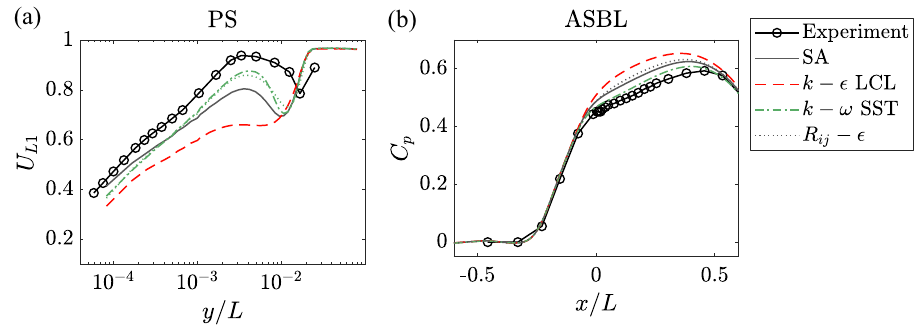
Figure 4. RANS results and the experimental data. Different lines are used for the results of different RANS models. Thin lines: SA model, dashed lines: k − ǫ LCL model, dot-dashed lines: k − ω SST model, and dotted lines: R ij − ǫ model. The RANS results are color coded. Green: “good” results, gray: “fair” results, and red: “poor” results. ( a ) PS results, ( b ) ASBL